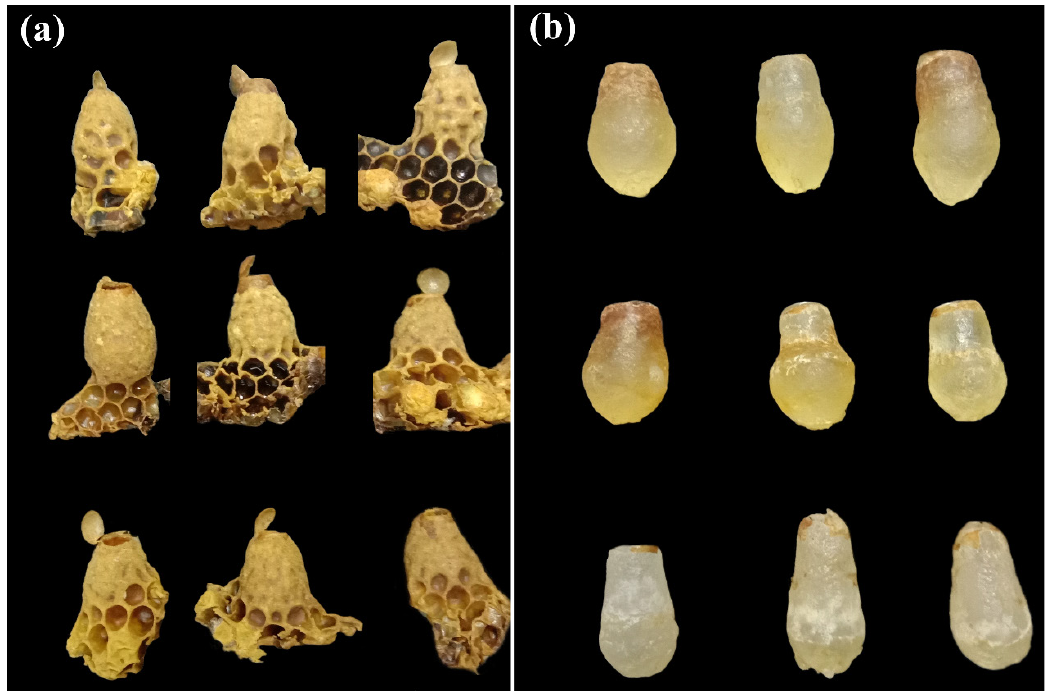
Fig 1 . (a) Swarm cells of the Eastern honey bee, Apis cerana cerana . (b) The molds of swarm cells for the Eastern honey bee, A. c. cerana. Top, queen cells in spring; middle, queen cells in summer; bottom, queen cells in